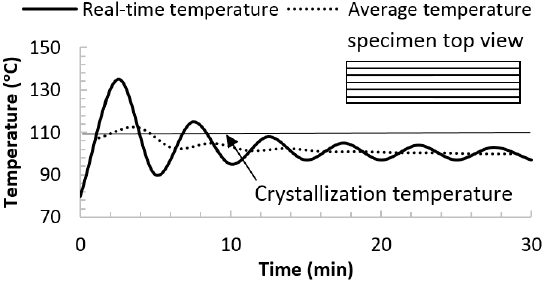
Figure 1. Cooling temperature profile of the bottom strand during extrusion-based additive manufacturing (Adapted from Sun [7]). manufacturing (Adapted from Sun